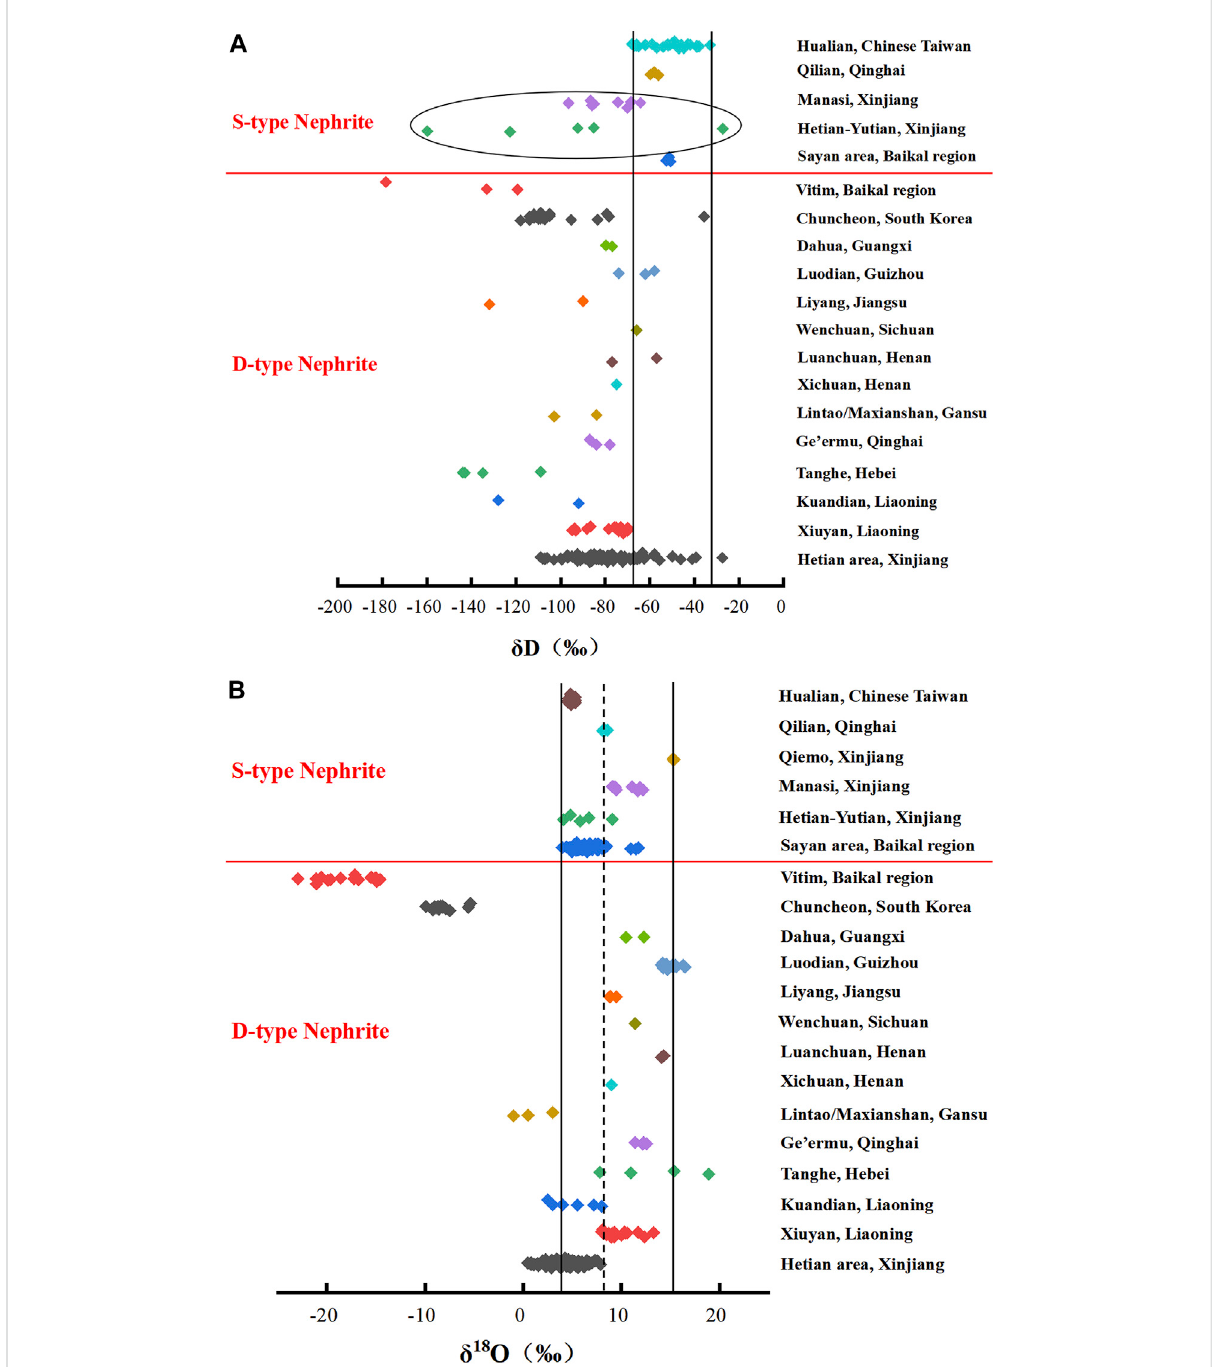
FIGURE 3 Hydrogen and oxygen isotopic values of nephrite deposits in China, Baikal region and South Korean Peninsula (The range of black lines in A represents the hydrogen isotope values of S-type nephrite in Hualian, Qilian and Sayan area, and the ellipse area represents the hydrogen isotope values of S-type nephrit in Xinjiang. The rang of black lines in B represents the oxygen isotope values of S-type nephrite, and the dashed line represents the lower limit of oxygen isotope values of most D-type nephrite.). (A) Hydrogen isotopic values (B) Oxygen isotopic